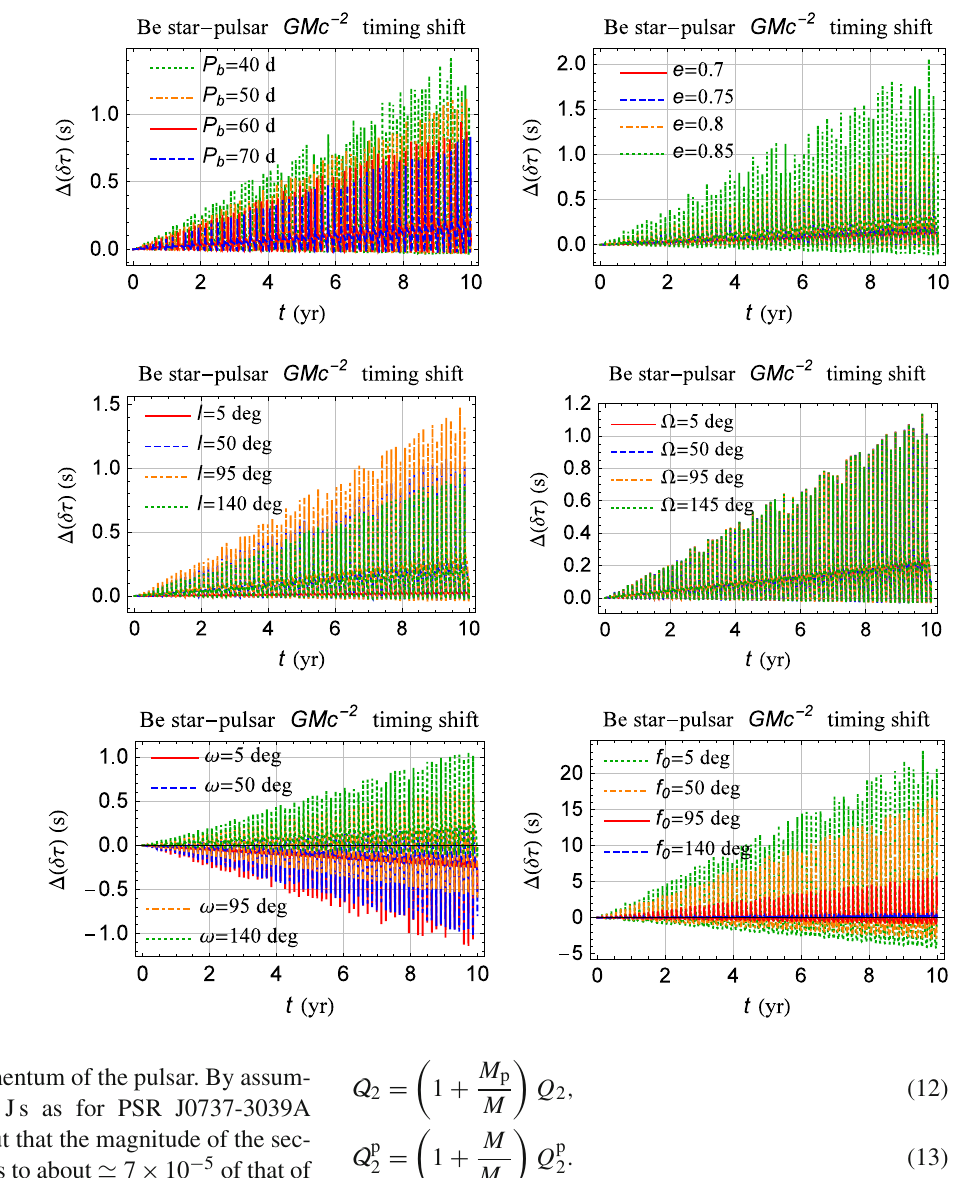
Fig. 2 Numerically integrated time series of the timing shift (cid:4)(δ τ ) due to Eq. (6), in s, for variations of the parameter space of a fictitious binary pulsar, characterized by P b = 50 days , e = 0 . 8 , I = 50 deg , (cid:12) = 140 deg , ω = 149 deg , f 0 = 228 deg, orbiting a Be-type star with M = 15 M